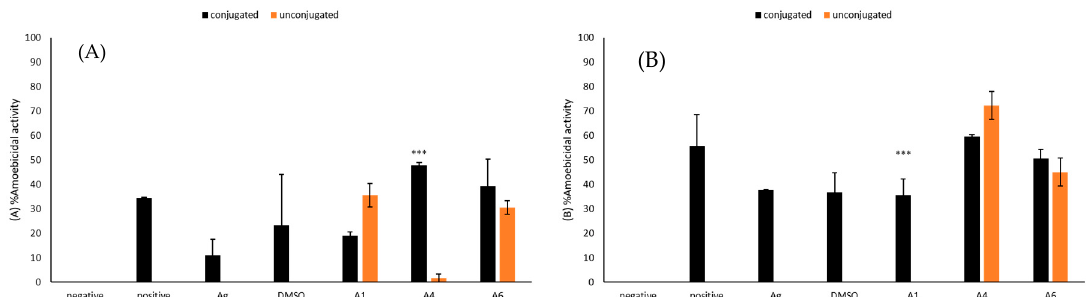
Figure 7. ( A ) The amoebicidal activities of azoles alone and those conjugated with silver nanoparticles were determined. The results show effects of azoles before and after conjugation on B. mandrillaris cells. ( B ) The results show effect of azoles before and after conjugation on N. fowleri cells. The results are representative of at least three independent experiments performed in duplicates. The data are presented as the mean ± standard error (***: p < 0.001 using 2 sample t test; two tailed distribution).